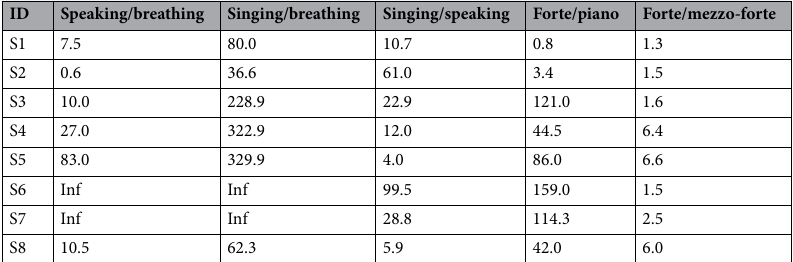
ID Speaking/breathing Singing/breathing Singing/speaking Forte/piano